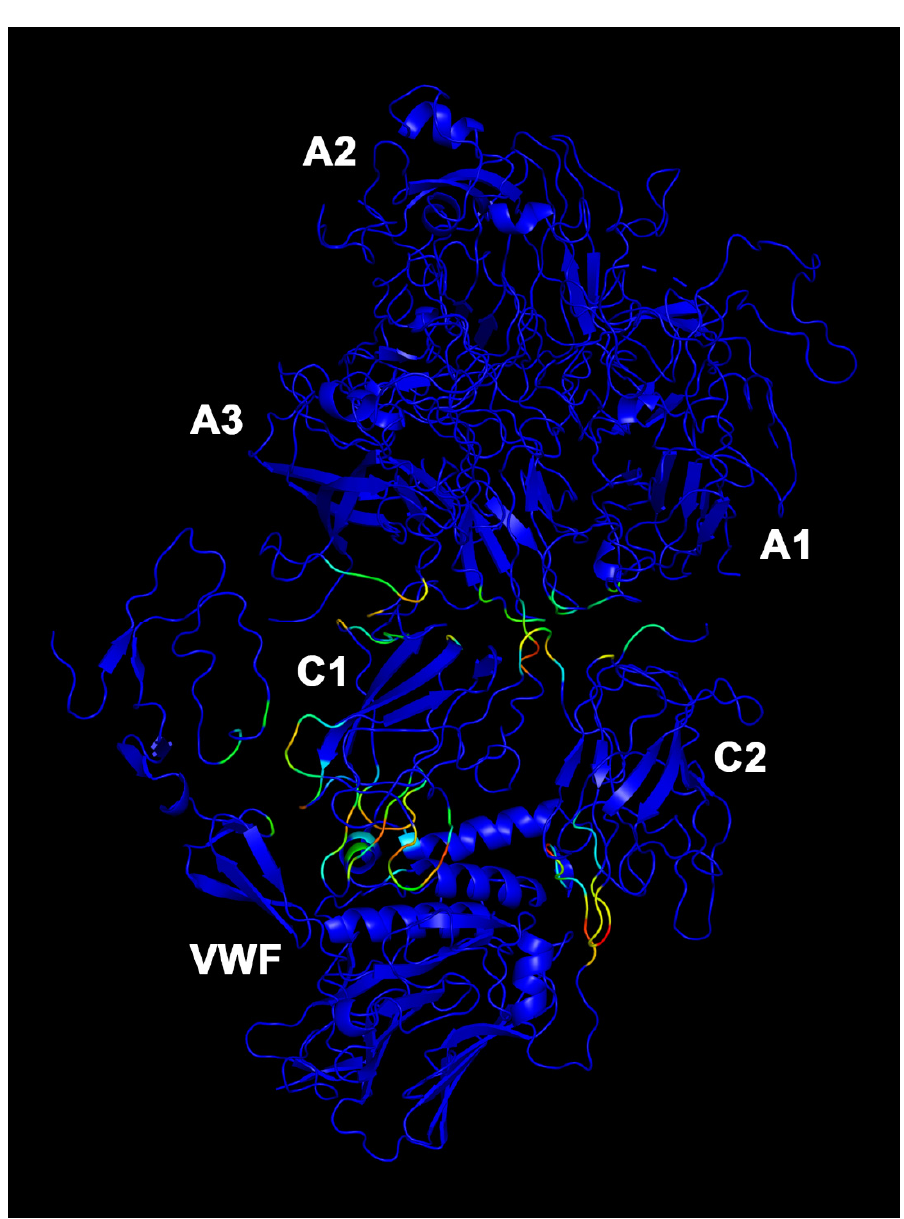
Figure 6. VWF/BDD-FVIII complex allosteric residues. Participation coefficient P heat map in color scale (blue to red, increasing values of P ). Blue residues have a P = 0. Capital letters refer to protein domains of FVIII.